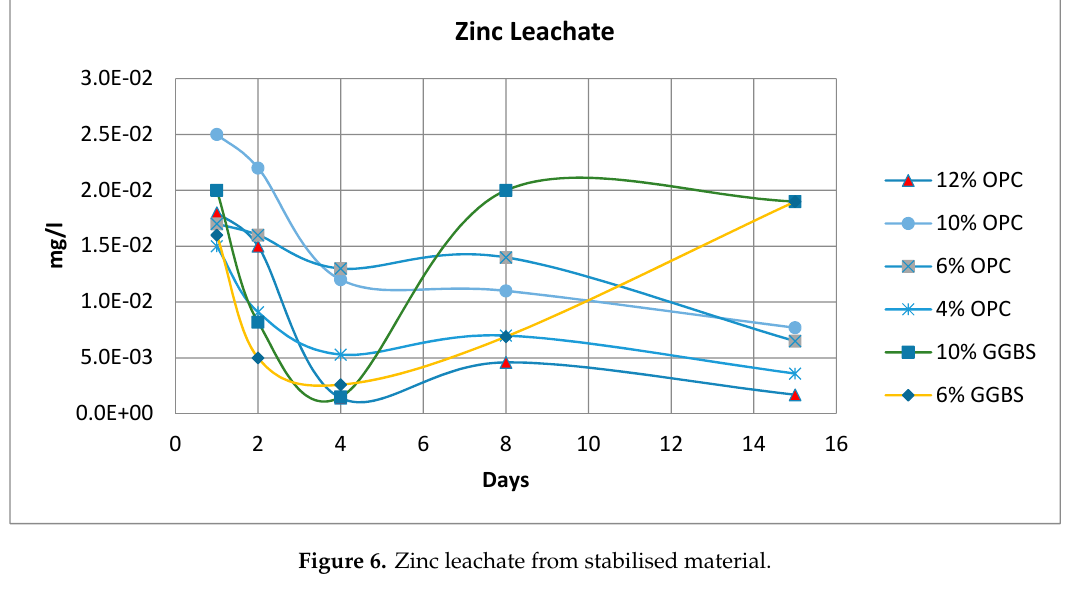
J. Mar. Sci. Eng. 2018 , 6 , x FOR PEER REVIEW Figure 6. Zinc leachate from stabilised material. Figure 6. Zinc leachate from stabilised material.